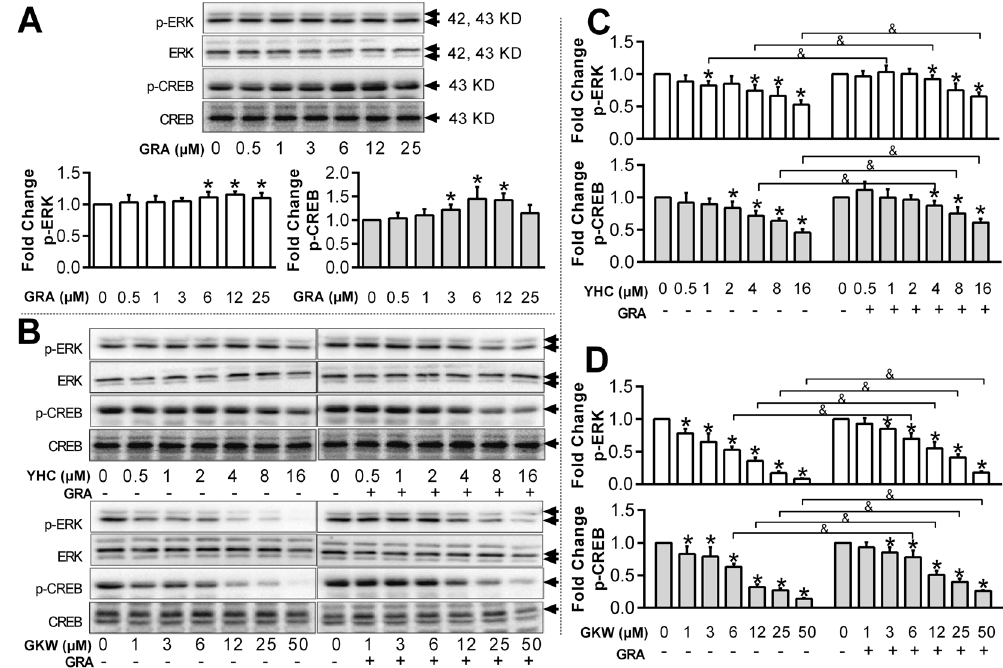
Figure 7. YHC, GKW dose-dependently decrease p-ERK and downstream p-CREB protein expression level, while GRA increase their protein expression level. The mIMCD3 cells were planted in 6 well plate and cultured in RPMI1640 medium supplied with 10% fetal bovine serum. All doses were given during cell logarithmic phase for 24 hours. ( A ) Blotting image of p-ERK, ERK, p-CREB and CREB expressed by mIMCD3 cells treated by GRA. Bar chart of fold changes are given, and concentrations are labeled behind. The blots was cropped properly and the full length blots are presented in Supplementary Fig. S9. ( B ) Blotting image of p-ERK, ERK, p-CREB and CREB expressed by mIMCD3 cells treated by YHC, GKW singly or in combination with GRA, for 24 hours. When GRA was combined, the working concentration was 12 μ M. The blots was cropped properly and the full length blots are presented in Supplementary Fig. S9. ( C to D ) Bar chart for p-ERK and p-ERK expression with different treatment. * P < 0.05 when compared with control group (none drug-treated), & P < 0.05 compared between groups with or without GRA treatment (n = 3). Total ERK and CREB level were used as internal reference respectively for calculating p-ERK and p-CREB expression. The involvement of ERK- MAPK pathway in AQP 2 expression are showed in Supplementary Fig.